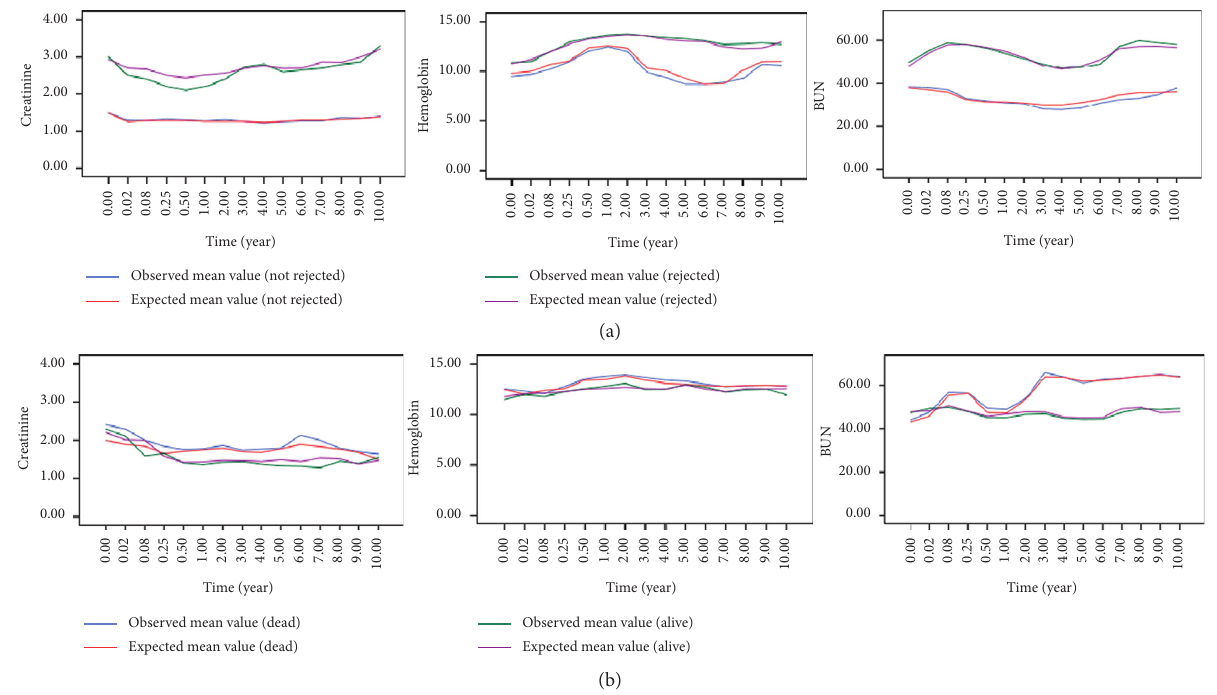
Figure 2: The mean of observed value of the longitudinal biomarkers (observed mean value) and the mean value of their predicted value based on the multivariate mixed effects model (expected mean value) over time based on (a) graft rejection status and (b) death (iv) The association structure takes into account the